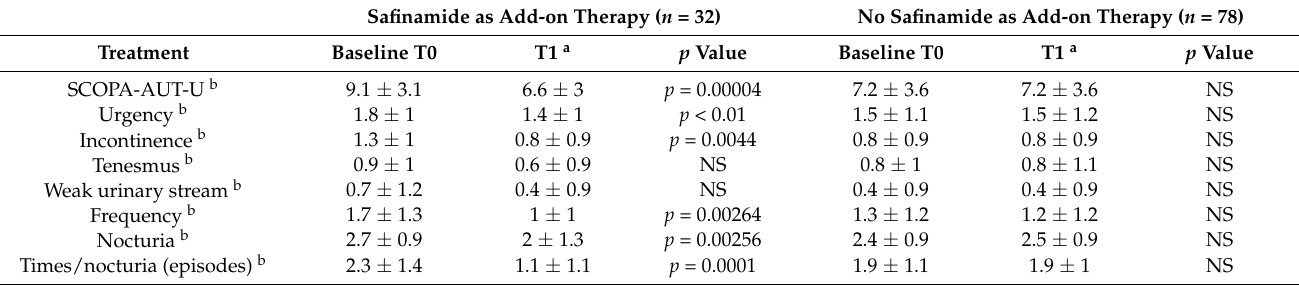
Table 3. Comparison of urinary symptoms in both groups after possible changes in